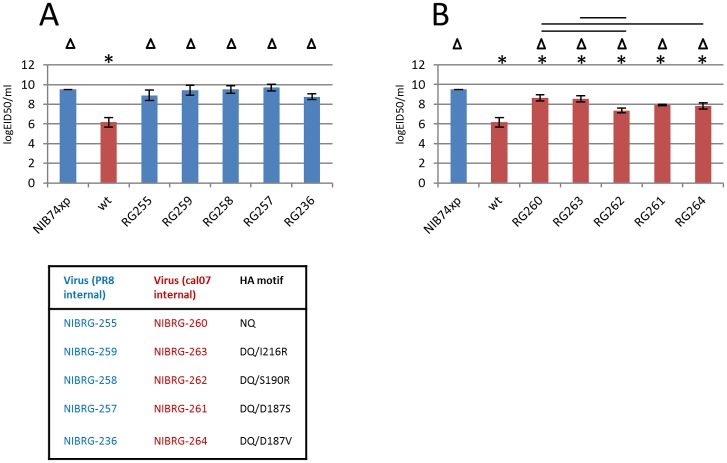
Infectivity of viruses.EID50 assays were performed and the results calculated as described in materials and methods. Panel A shows data for viruses with PR8 internal genes (in blue) compared to Chr/16 wt (in red). Panel B shows the data for viruses with A(H1N1)pdm09 internal genes (in red) compared to NIB74xp (in blue). In each panel the asterisks (*) denote a statistically significant difference to NIB74xp (p<0.05), and a triangle (Δ) denotes a statistically significant difference to Chr/16 wt (p<0.05). The black bars denote statistically significance differences (p<0.05) between the other viruses. Values shown are the average of three independent experiments and error bars show standard deviations.